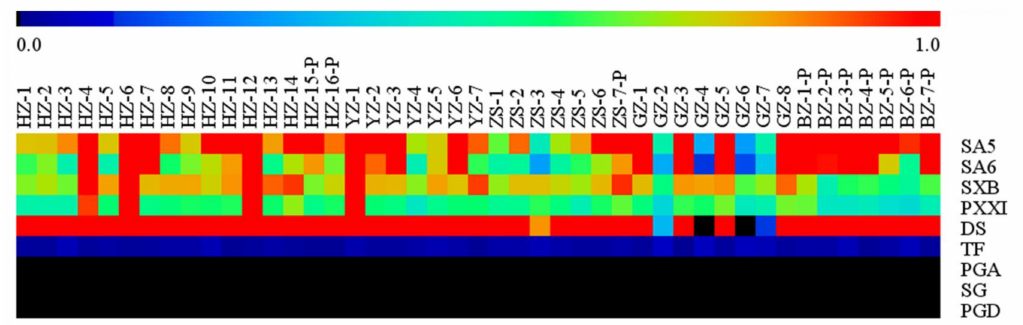
Figure 3. The heat map of relative concentration of the targeted compounds in forty-five